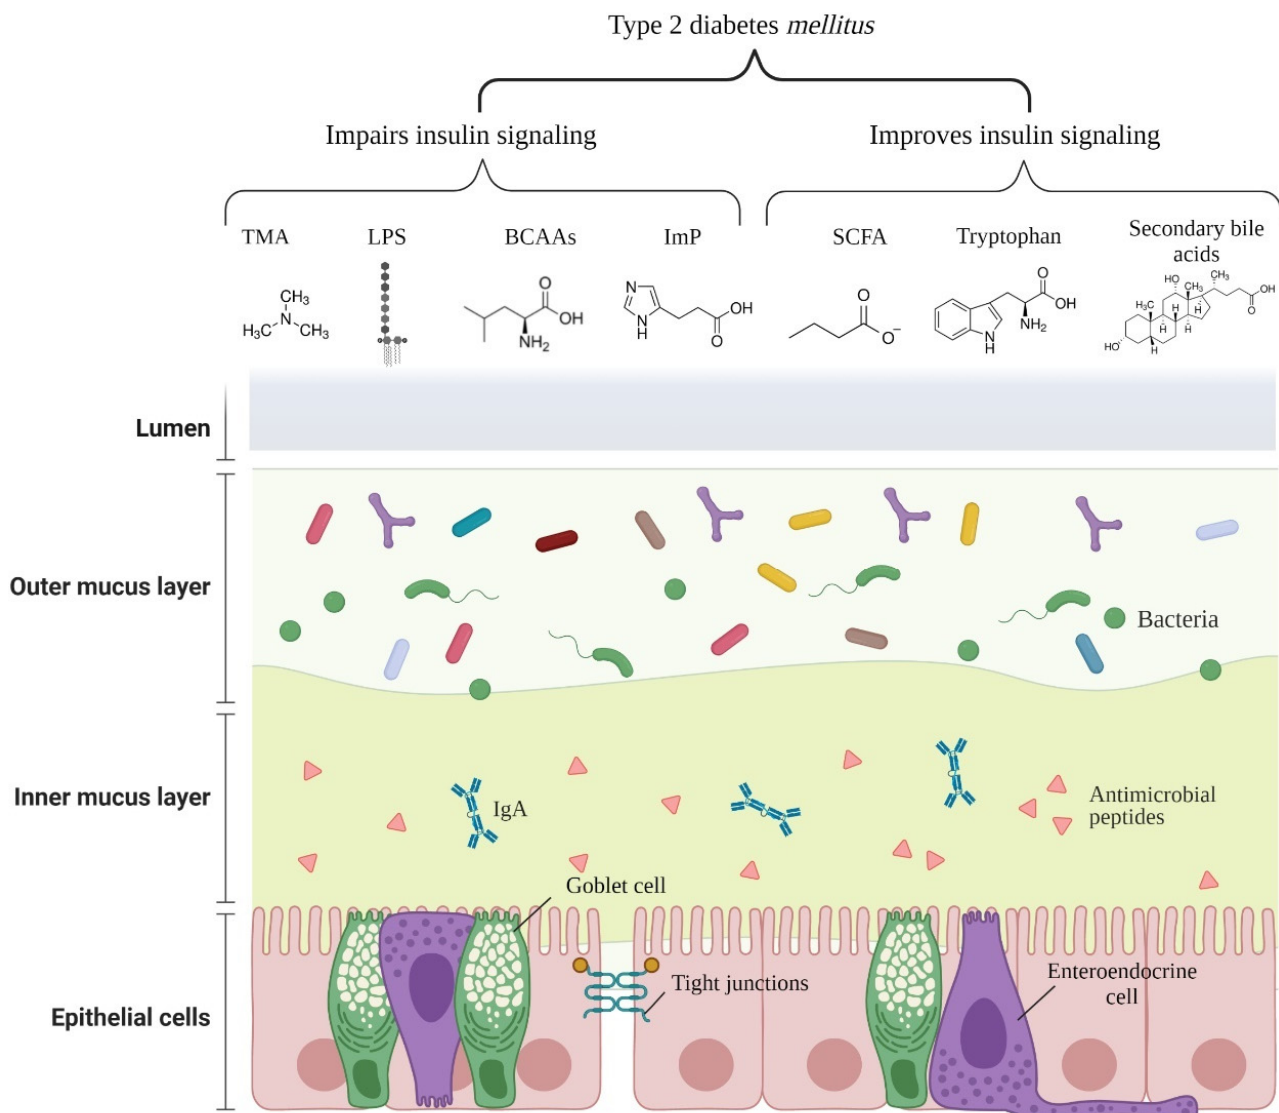
Figure 2. Main microbial components/metabolites affecting insulin signaling in type 2 diabetes mellitus . Abbreviations: TMA: trimethylamine; LPS: lipopolysaccharide; BCAAs: branched-chain amino acids; ImP: imidazole propionate; SCFA: short chain fatty acids; IgA: immunoglobulin A. (Get permission from BioRender. 18 October 2021)